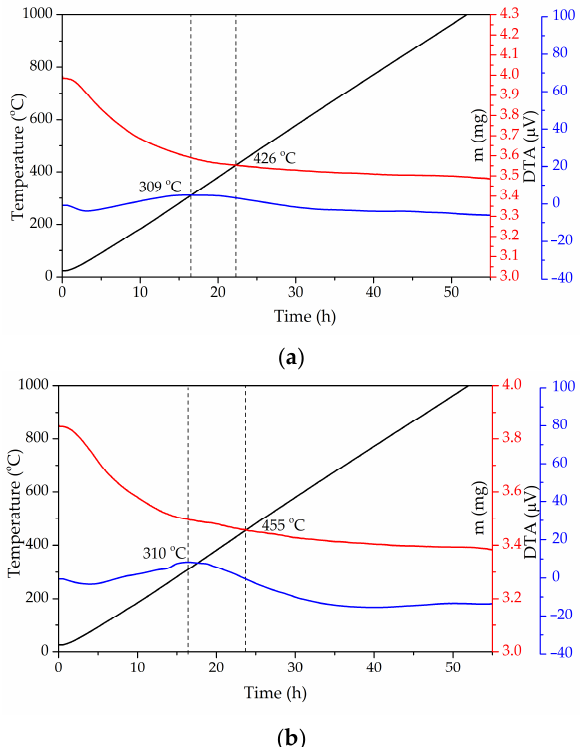
Figure 3. TGA (red curve)/DTA (blue curve) curves of ( a ) natural and ( b ) modified zeolite with temperature line (black line).